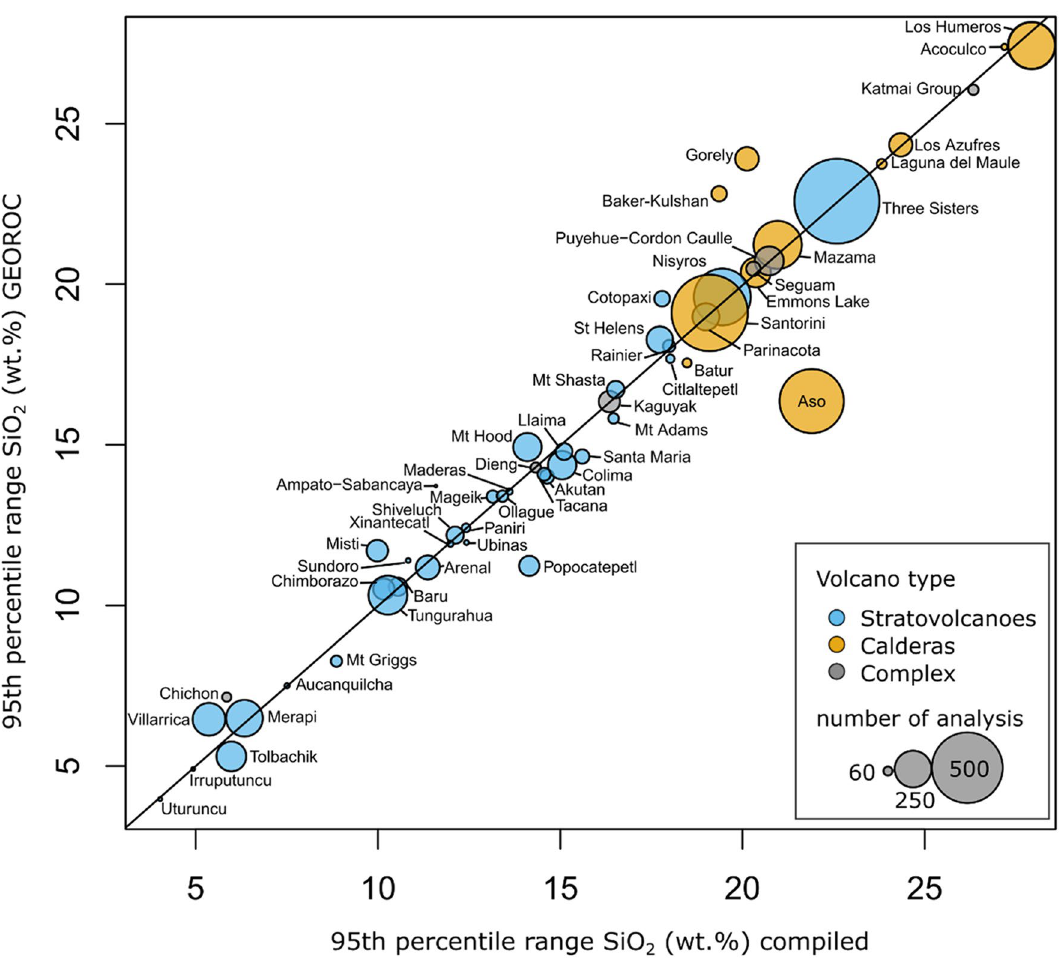
Figure 2. Comparison of erupted bulk-rock SiO 2 contents in the GEOROC database and compilation. The compiled range of erupted compositions shown as 95th percentile ranges of the SiO 2 contents (wt%) for each volcanic system is compared to the unfiltered range from the GEOROC database (http:// georoc. mpch- mainz. gwdg. de/ georoc/). Black line indicates a 1:1 relation. Symbol size is proportional to the number of analysis in the compiled dataset. Colour coding reflects volcano type: Stratovolcanoes (blue), Calderas (orange), Complex